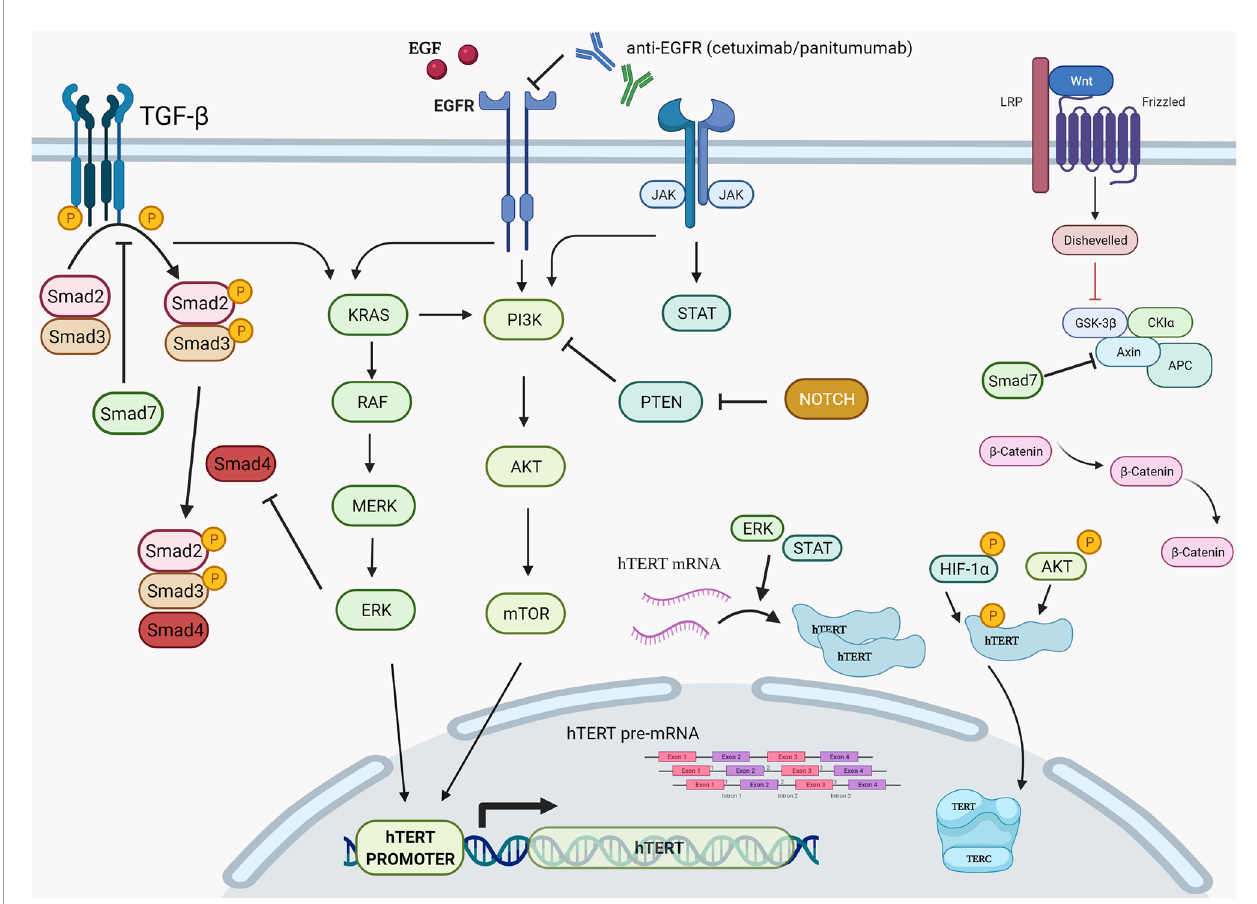
FIGURE 4 | Graphical presentation of the various cellular cascades implicated in hTERT expression, telomerase activity, and telomere length. During transcription of hTERT gene, positive regulation is exerted via the PI3K/AKT/mTOR, the RAS/RAF/MEK/ERK 1/2, and the JAK/STAT pathways primarily on hTERT ’ s promoter. Another step of positive regulation is found during the translation and post translation phase of hTERT mRNA since the RAS/RAF/MEK/ERK pathway is described to regulate hTERT mRNA translation, while the PI3K/AKT/mTOR pathway seems to be involved post-translationally via direct phosphorylation of hTERT by AKT and HIF-1 a . RAS, rat sarcoma; RAF, rapidly accelerated fi brosarcoma; MEK also known as MAP2K, MAPKK, mitogen-activated protein kinase kinase; ERK, also known as MAPK, extracellular signal-regulated kinase; PI3K, phosphatidylinositol 3-kinase; PKB, also known as Akt, protein kinase B; Mtor, mechanistic target of rapamycin kinase; HIF-1 a , hypoxia-inducible factor-1 a . Created with